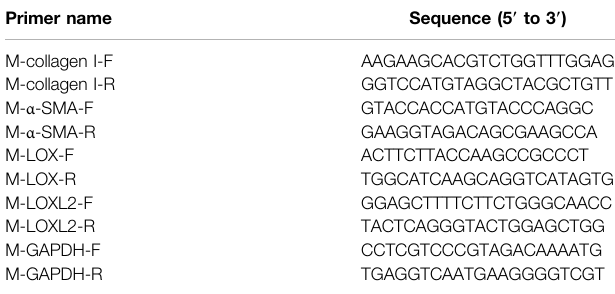
TABLE 1 | Primers for quantitative